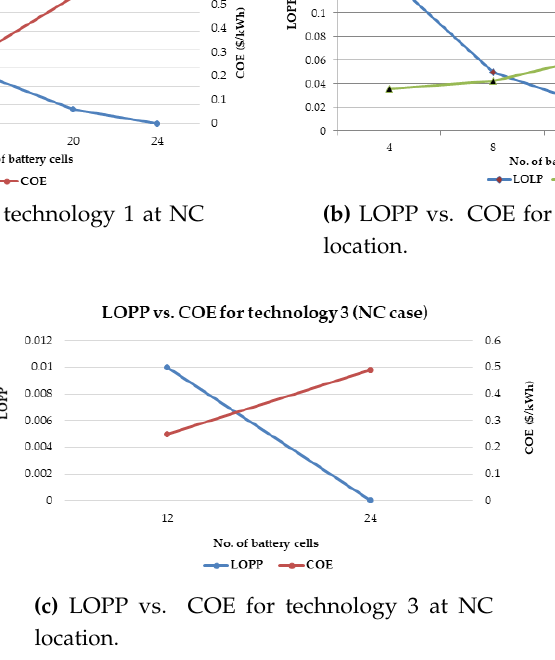
Figure 14. Technology selection for NC